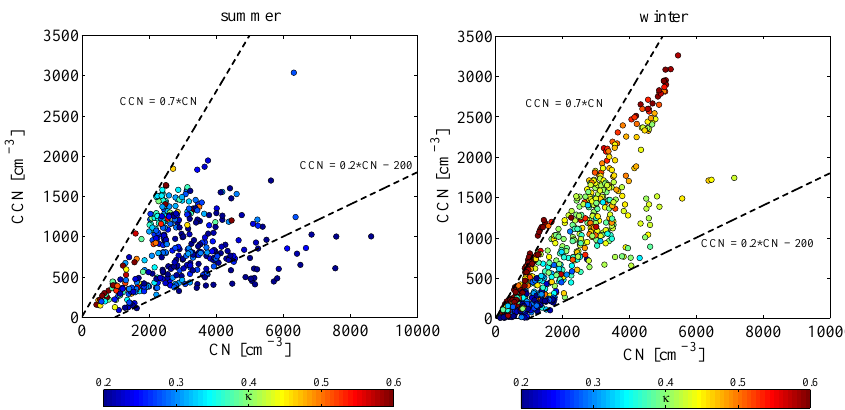
Fig. 4. CCN 0 . 24 concentration as a function of the total particle number concentration (CN) separately for summer (left) and winter (right). Colour shows the hygroscopicity parameter κ value with scale ranging from 0.2 to 0.6. Dashed linear lines show the visually defined boundaries in within most of the data are centered.